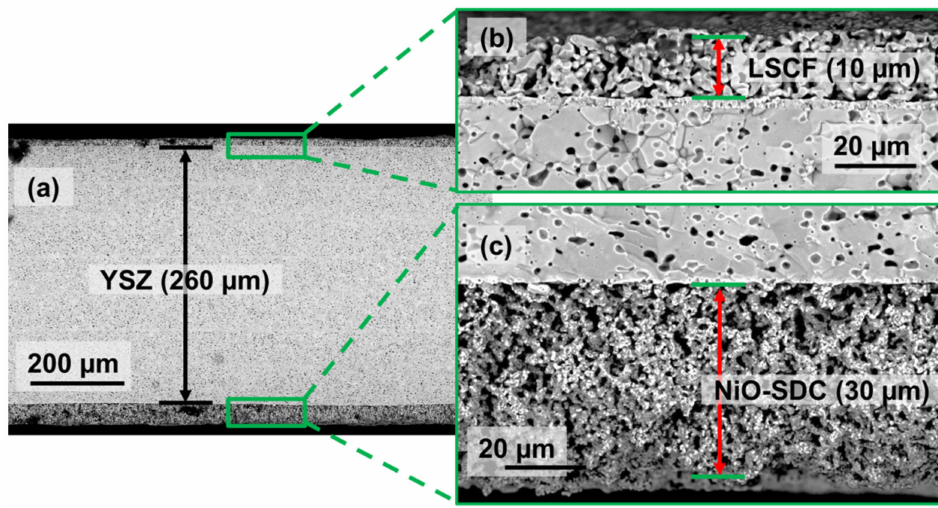
Figure 2. Cross-sectional FESEM images of NiO–SDC/YSZ/LSCF single SOFC: ( a ) single cell at low magnification, ( b ) LSCF cathode, and ( c ) NS-GNP cermet